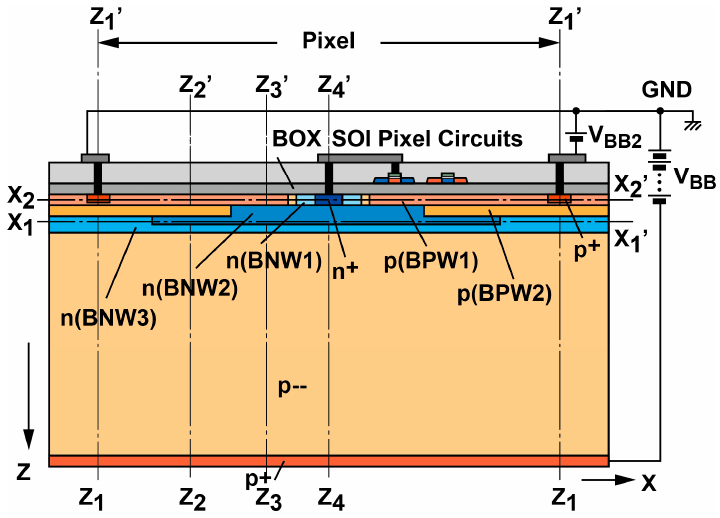
Figure 3. Cross-sectional view of the SOIPIX-PDD with multiple buried wells.